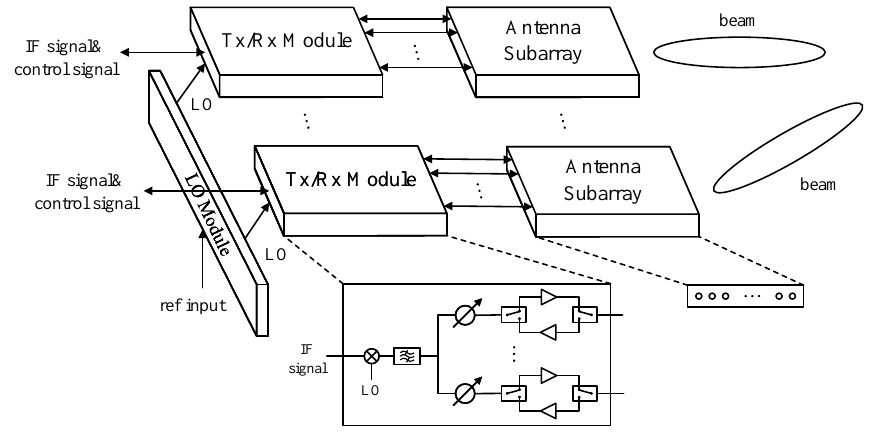
Figure 2. The architecture of the phased antenna array. Phase shifters, amplifiers and switches in Tx/Rx modules are controlled by the control signal, and the control circuit is